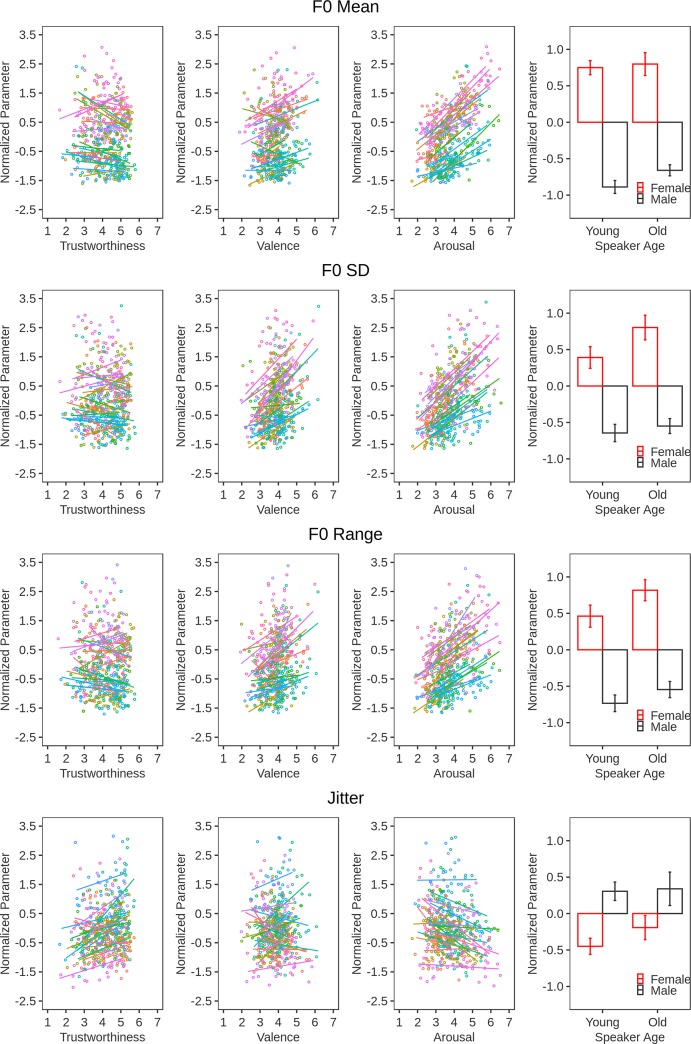
Illustration of the relationship between acoustic measures (i.e., F0 mean, F0 SD, F0 range, jitter) and other stimulus properties.Normalized vocal parameters (y-axes) are plotted as a function of trustworthiness ratings, valence, arousal, and speaker characteristics (x-axes). The individual points in the scatter plots represent the 13 expressions for the 2 sentences produced by each speaker. These points are summarized by a regression line for each speaker. The error bars in the bar-graphs represent the 95% confidence intervals.